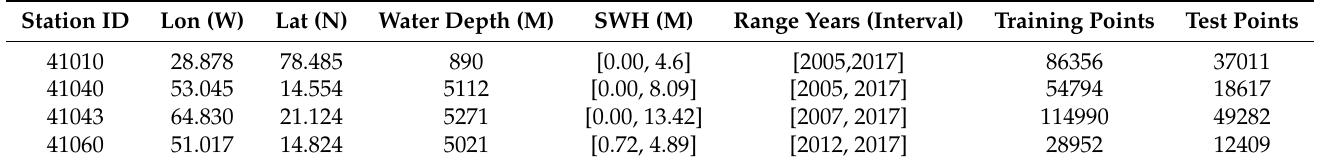
Table 1. Stations’